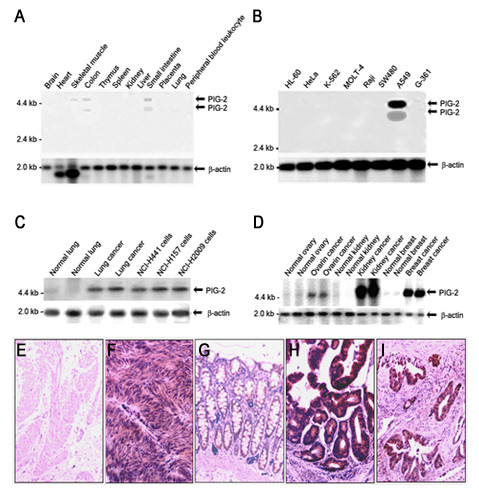
Expression of PIG-2 in human tissues by Northern analyses and immunohistochemical studies. Northern blotting analyses were performed to determine the expression of PIG-2 in different human tissues. Normal 12 lane multiple tissue northern blot (A) or human cancer cell line multiple northern-blot purchased from Clontech (B) was probed with a radioactively labeled CC282 partial cDNA (upper panel) or human β-actin cDNA control probe provided by Clontech (lower panel). (C) Total RNAs were isolated from normal lung tissue, primary lung cancer and from NCI-H441, NCI-H157 and NCI-H2009 lung cancer cell lines. Blot was hybridized with the randomly primed [32P]-labeled PIG-2 partial cDNA probe (the CC282 fragment). Human β-actin cDNA was used as a control probe (lower panel). (D) Comparison of PIG-2 mRNA expression in human tumor tissues and their corresponding normal counterparts (upper panel). Total RNAs were extracted from fresh human normal and cancer tissues. The same blot was probed with β-actin as a loading control (lower panel). (E-I) Immunohistochemical staining for PIG-2 expression of human normal muscle (E), leiomyosarcoma (F), normal colon tissue (G), colon cancer (H), and pancrease cancer tissue (I), Original magnification, × 100.